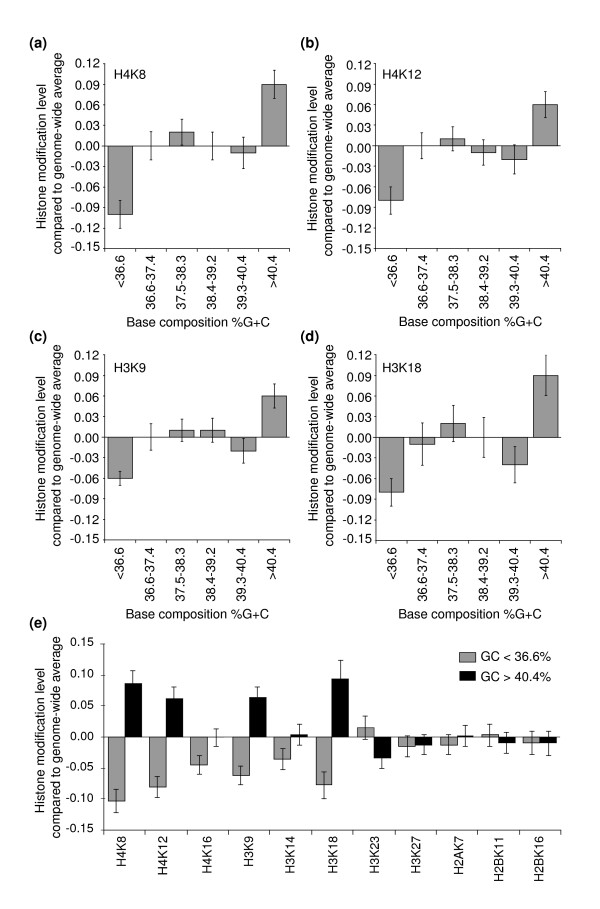
GC-rich and AT-rich genes differ in levels of acetylation of specific histone tail residues in wild-type cells. Genes were grouped in six groups dependent on the average base composition of the 4 kb region centered on the start site of the gene. For each group average levels of acetylation of different histone tail residues were determined using a dataset obtained by Kurdistani and co-workers [36]. (a-d) GC-rich genes display higher levels of H4K8, H4K12, H3K9 and H3K18 acetylation compared to AT-rich genes. (e) Comparison of the average levels of 11 histone modifications for GC-rich genes (GC > 40.4%) and AT-rich genes (GC < 36.6%). H3 and H4 acetylation is higher for GC-rich genes, whereas H2A and H2B acetylation is not different for the two types of isochore domains.